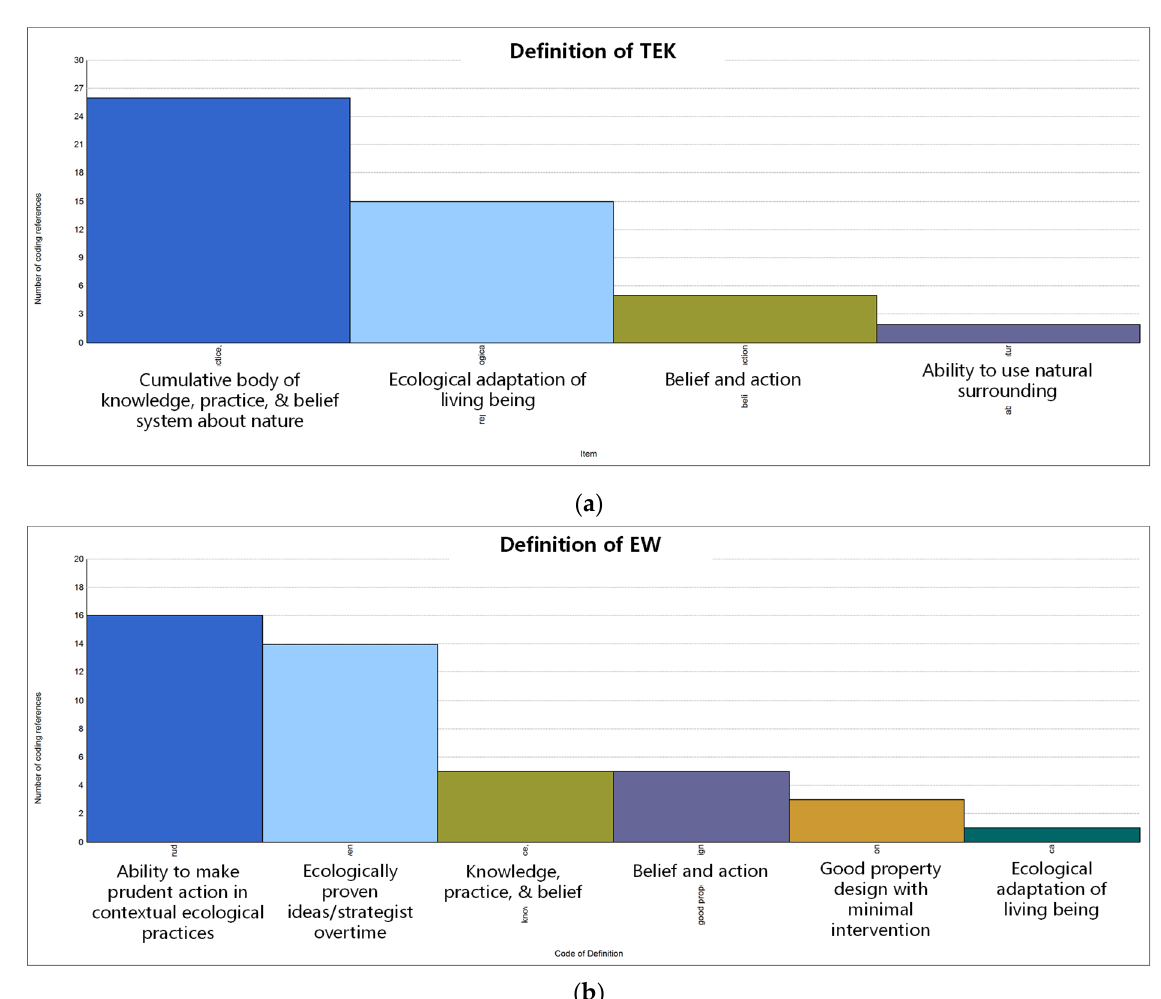
Figure 4. The definition of TEK ( a ) and EW ( b ) is based on the number of coding references, respec-